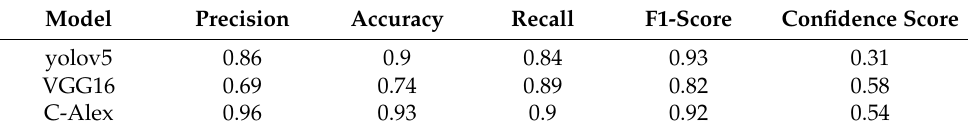
Table 4. Parameters evaluated for each of the three models through the test